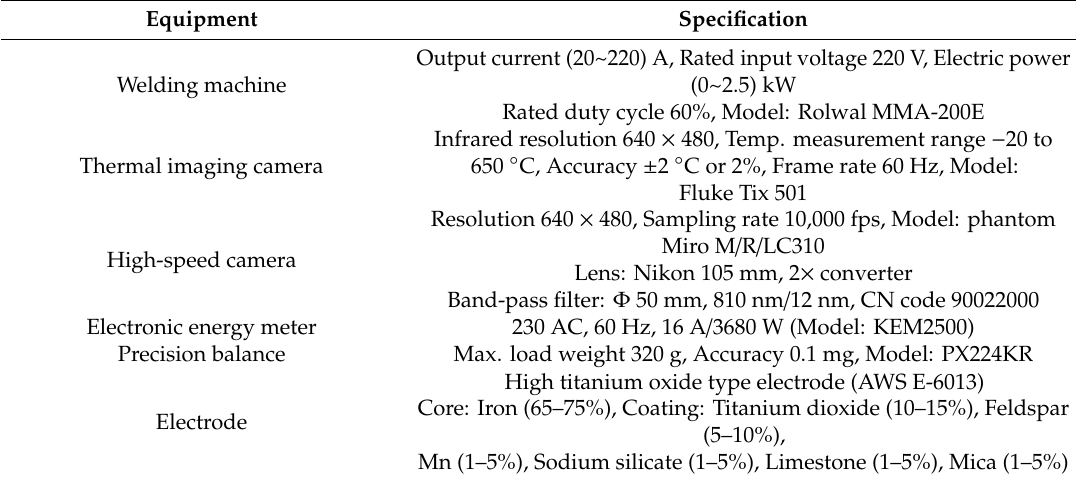
Figure 2. Schematic and images of experimental apparatus for welding spatter analysis. Table 1. Specifications of experiment apparatus.